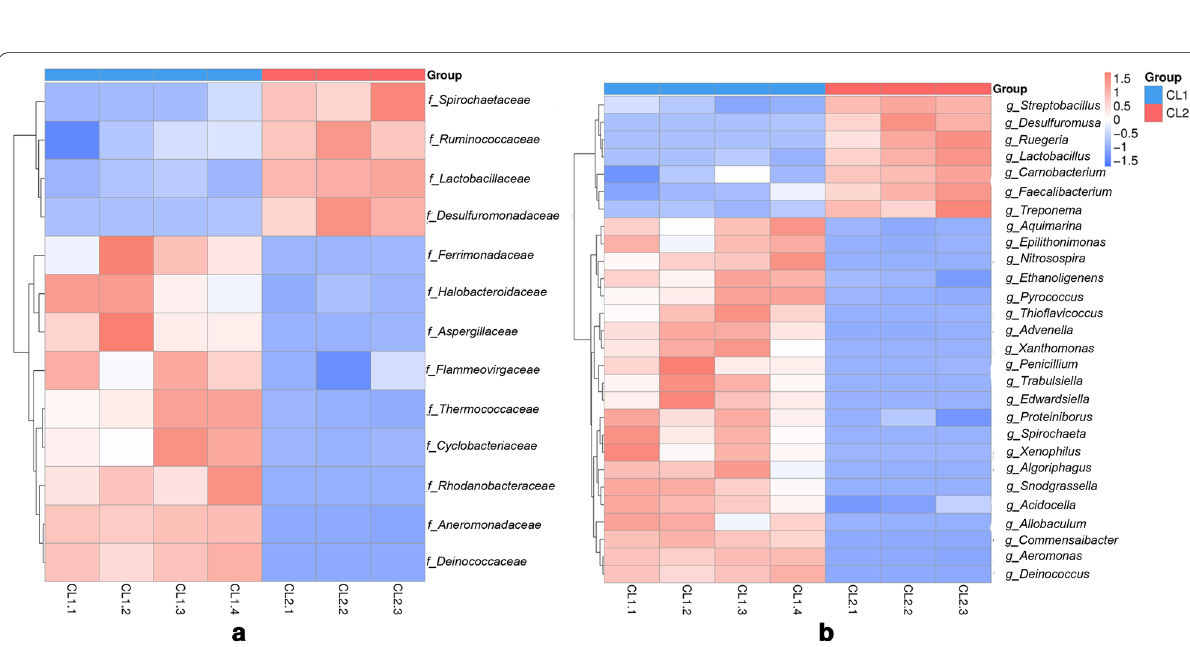
Fig. 3 The abundance clustering based on significant differences in species at a the family level and b the genus level. Horizontal represents sample information; vertical information represents annotated information of species; the cluster tree on the left is the species cluster tree. The values corresponding to the intermediate heat map are the Z values of the relative abundance of each row of species after standardized